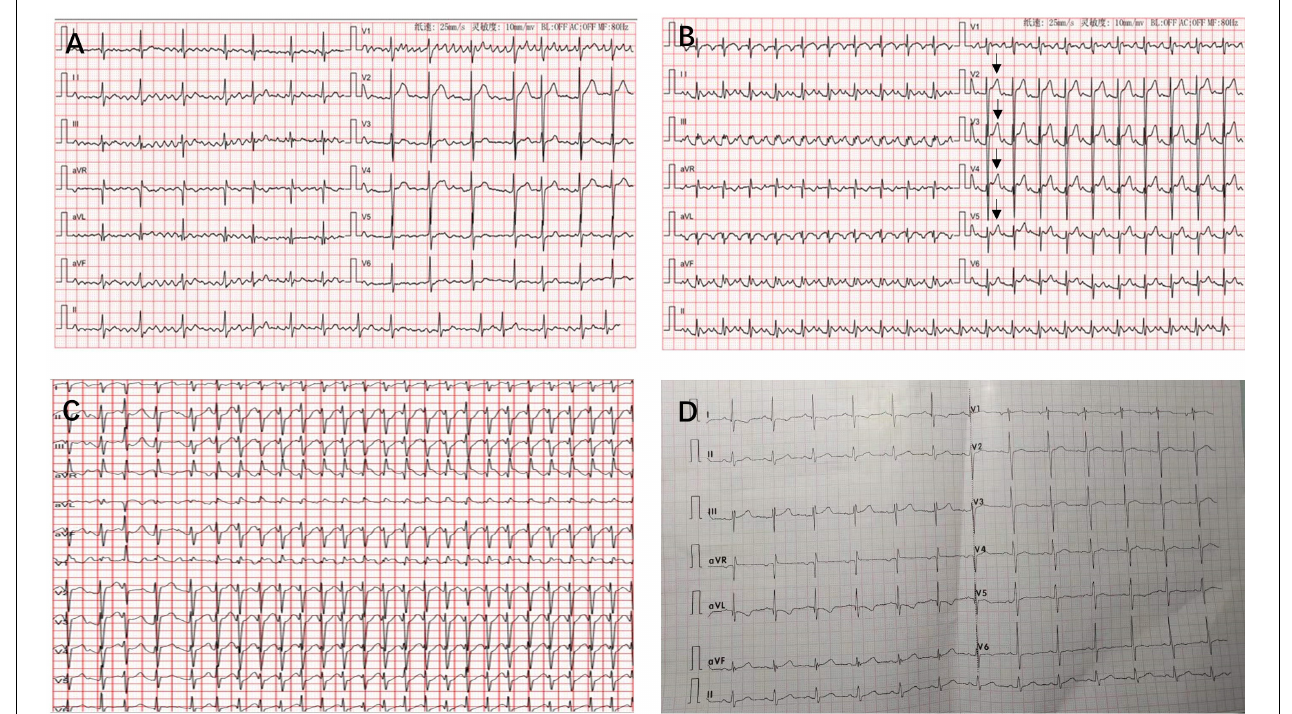
FIGURE 1 | Twelve-lead electrocardiograms revealing atrial fibrillation (A) , atrial flutter with mild ST-segment elevation in leads V2–V5 (arrows) (B) , atrial tachycardia with a rapid ventricular rate of 238 beats/min was recorded when he was experiencing attacks of atrial tachycardia (C) , and sinus rhythm at 6-month follow-up (D)